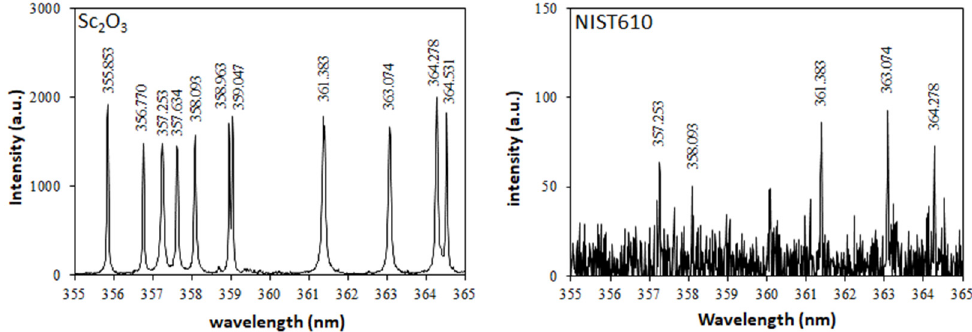
Figure 4. LIBS spectral region 355–365 nm with Sc II lines for the Sc 2 O 3 concentrate and NIST610 standard.